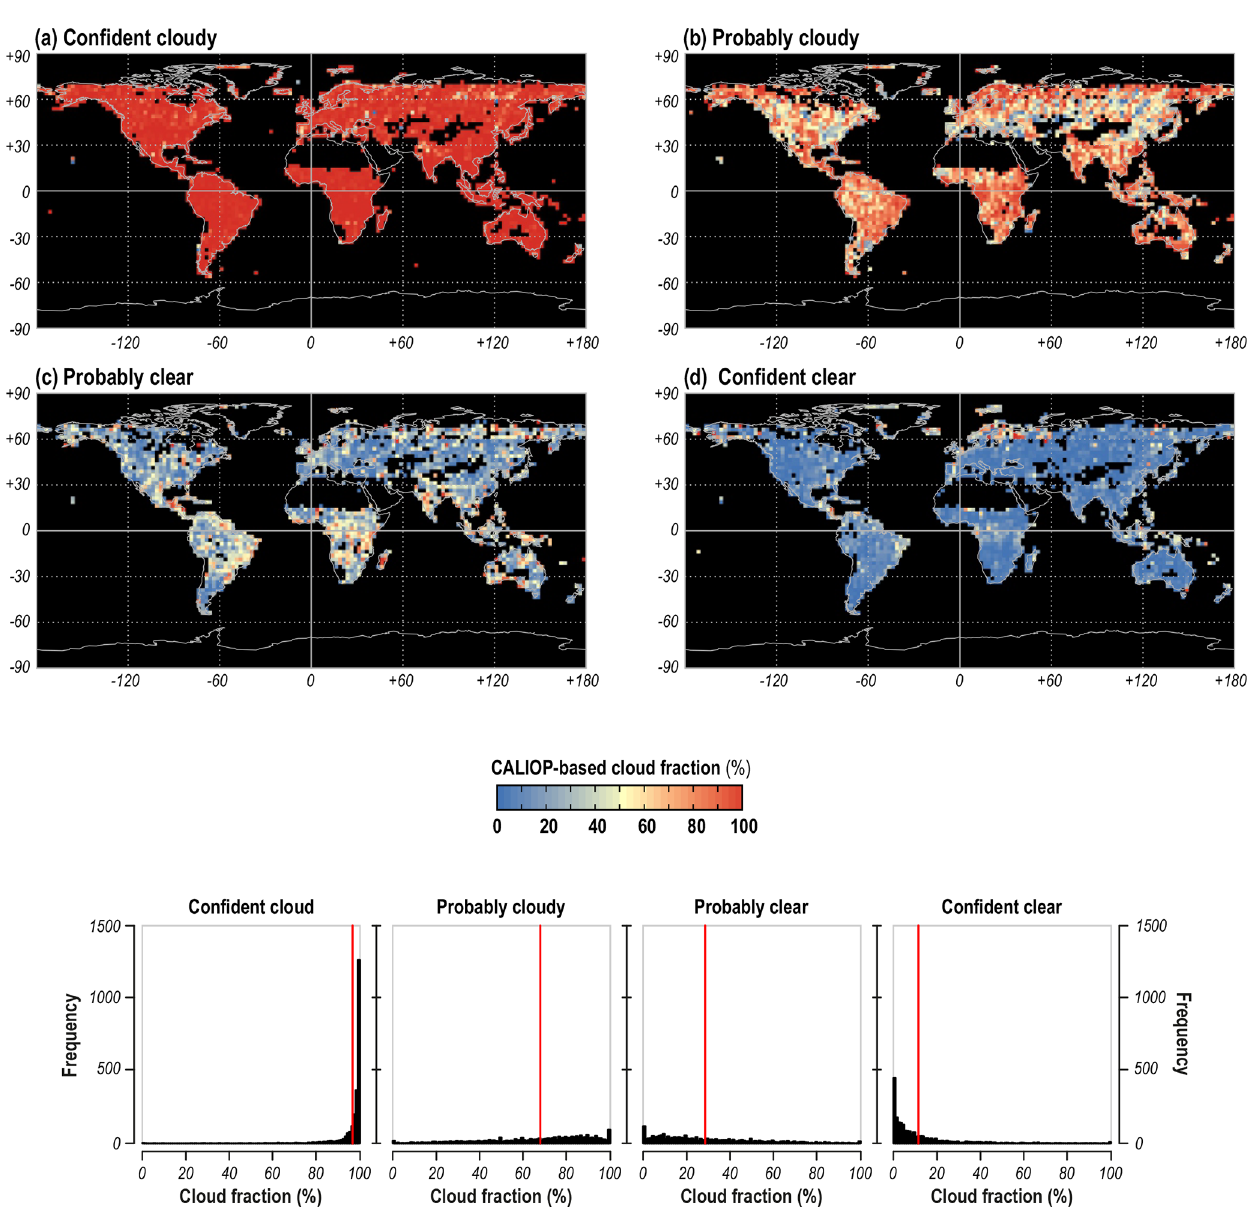
Figure 5. CALIOP-based cloud fraction for MODIS cloud mask classes for the “nighttime snow-free land” algorithm path and corresponding histograms (red vertical line indicates the mean